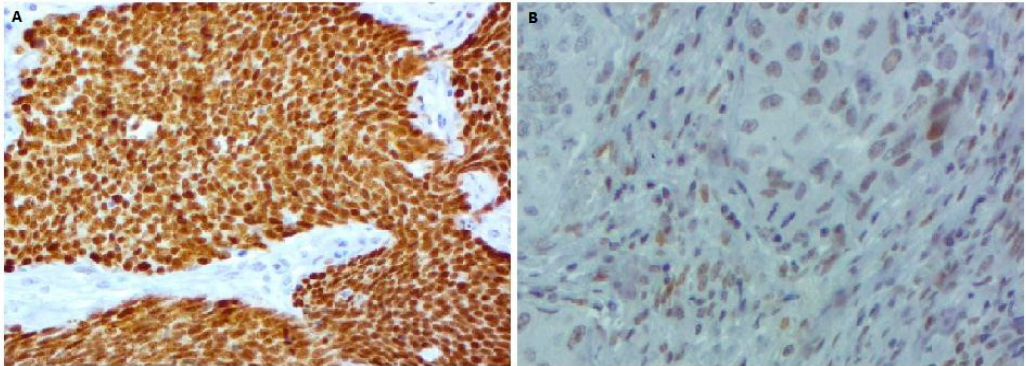
Figure 7. P53 protein expression in lung adenocarcinoma: ( A ) strong immunostaining (p53 score = 12), ( B ) low immunostaining (p53 score = 4) (400×).